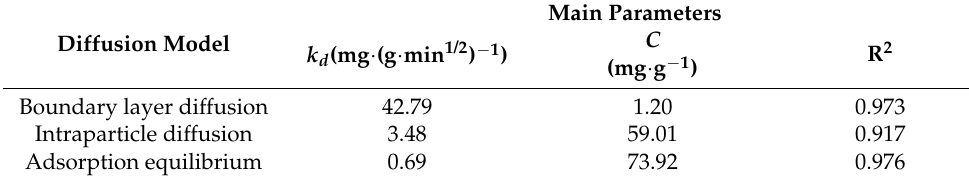
Table 5. Comparison of adsorption capacity of MB on diversified adsorbents.